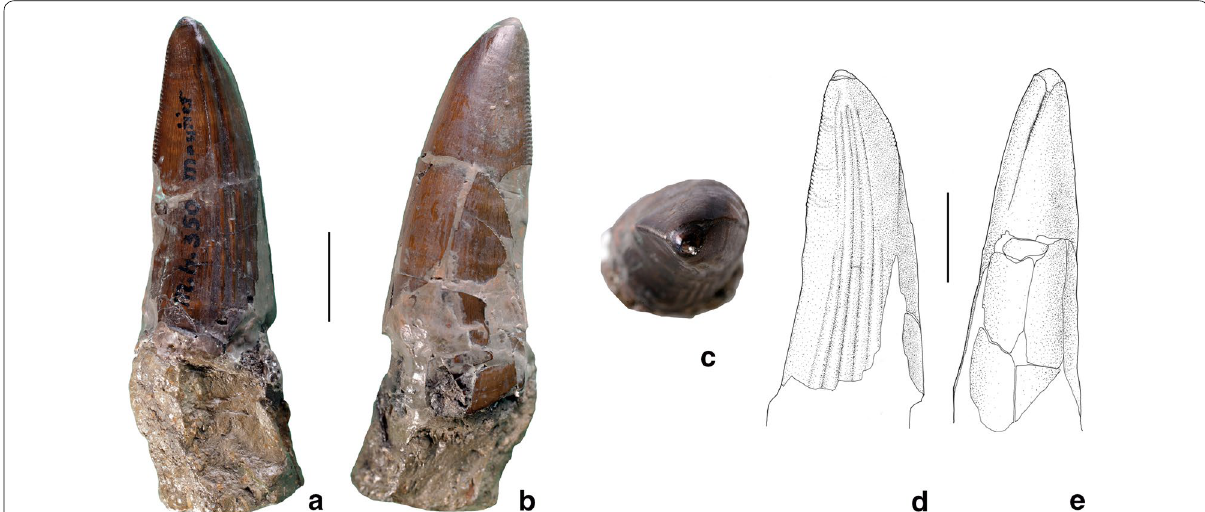
Fig. 15 M.H.350, tooth of indeterminate member of Ceratosauria, photographs in a lingual, b labial and c apical view. Interpretative drawing in d lingual and e rostrolabial views. Scale bar is 10 mm. Drawings by Serafin